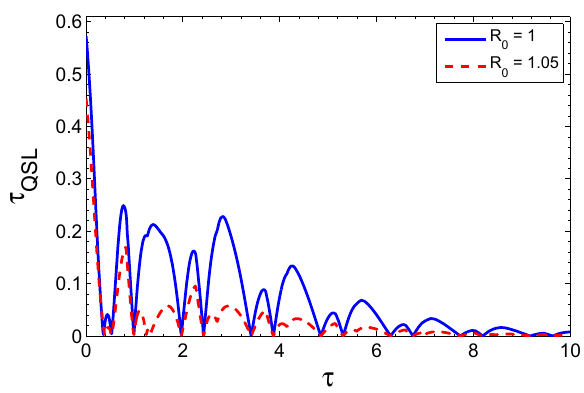
Fig. 4 The QSL-time for the damped Jaynes-Cummings model as a function of the initial time parameter τ . The coupling is weak i.e. γ 0 = 10 λ and Ω = 10